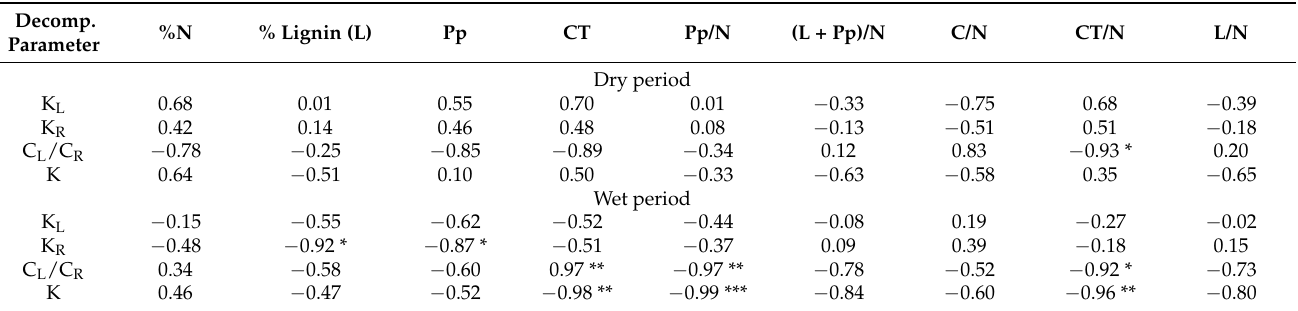
Table 4. Correlation coefficients (r) among N release and leaf chemical quality for the dry and rainy periods.